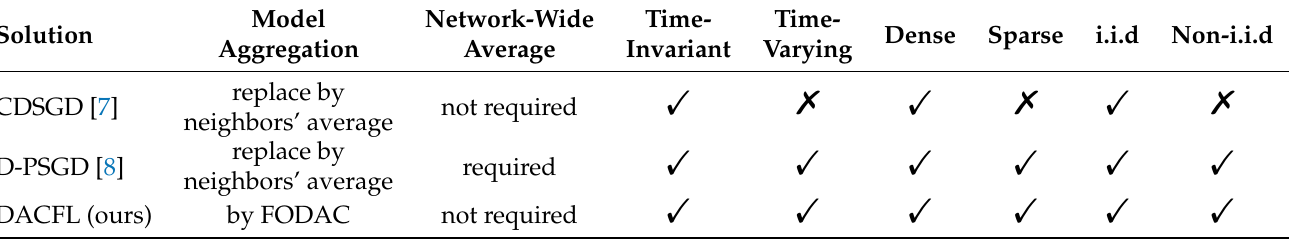
Table 1. Comparison with CDSGD, D-PSGD. (cid:33) means enabled and (cid:37) means disabled in our